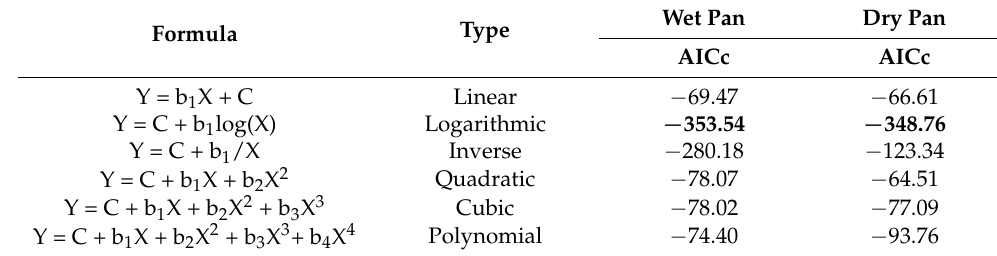
Figure 5. Vegetation diversity (Rao’s Q) derived from measures of spectral variation: ( a ) all the spectral bands, ( b ) coefficient of variation, ( c ) Normalised Difference Phenology Index (NDPI), and ( d ) principal component. Table 1. Curve estimation models for estimating the relationship between remotely sensed diversity (Rao’s Q) and distance from the wet natural pans. Y represents the vegetation diversity, b denotes the constant, C represents the intercept, and X is the distance from the wet natural pans. The bold values show the relationship that was significant and had a lower AICc for each